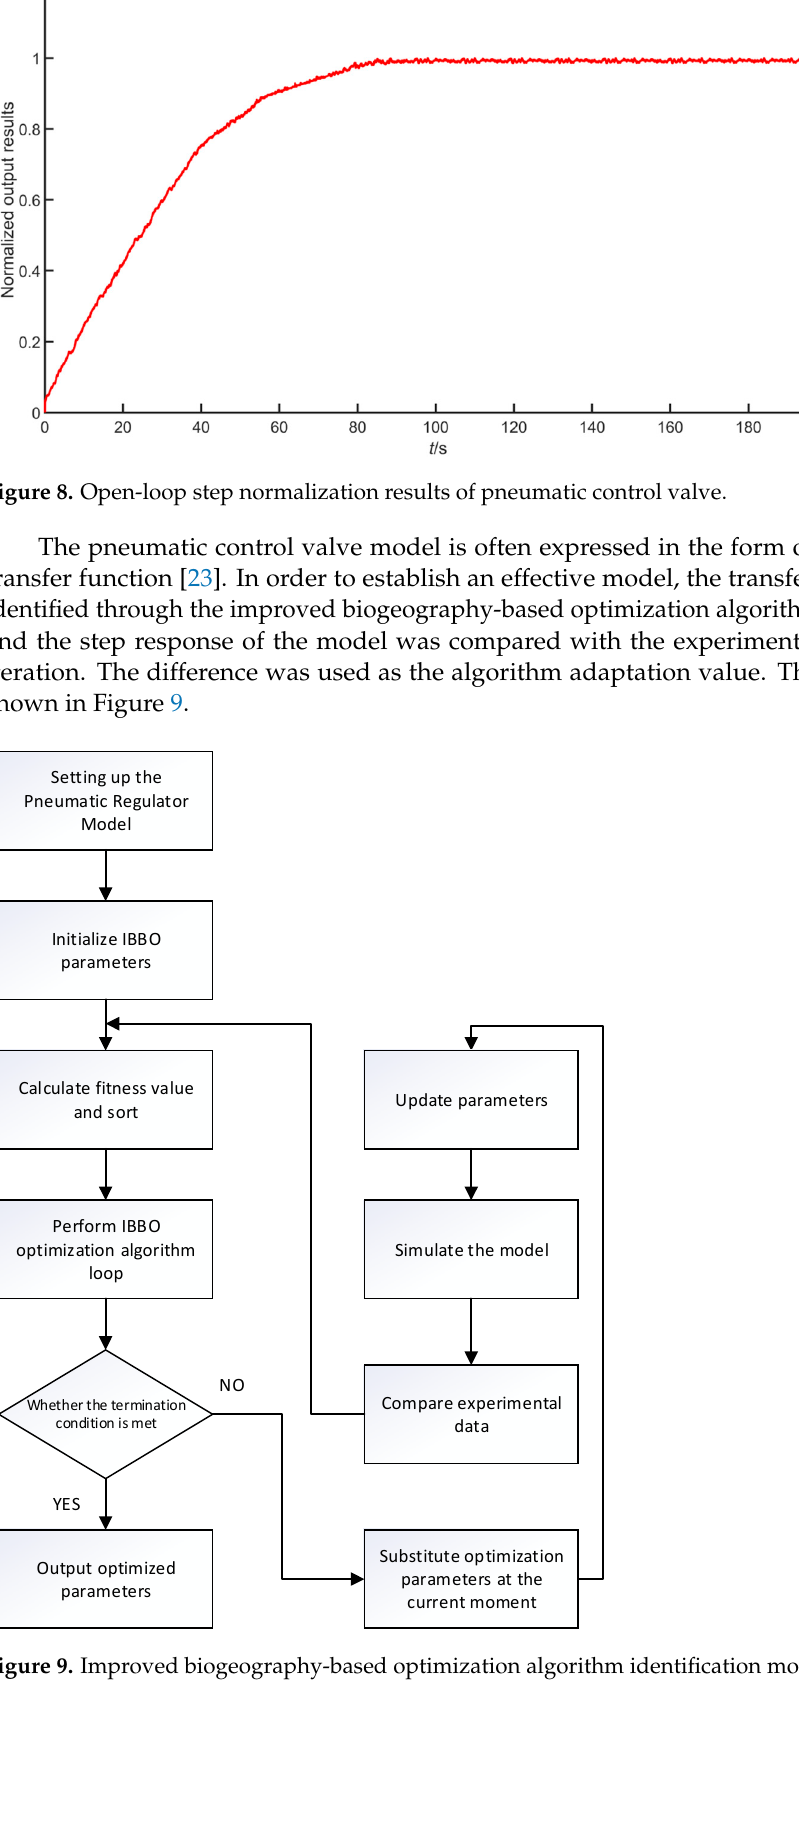
Figure 10. Identify fit plots.